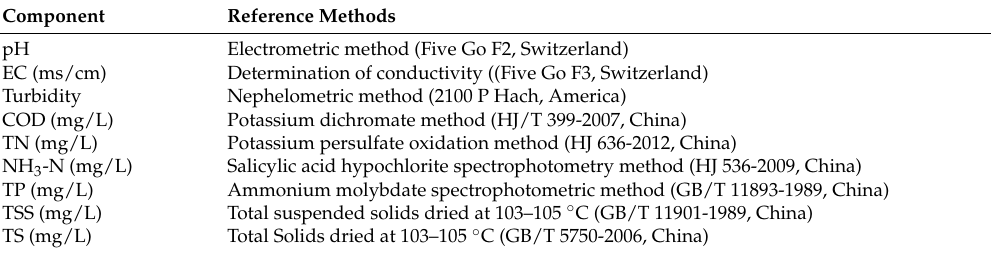
Table 2. The summary of physico-chemical analysis methods considered in this